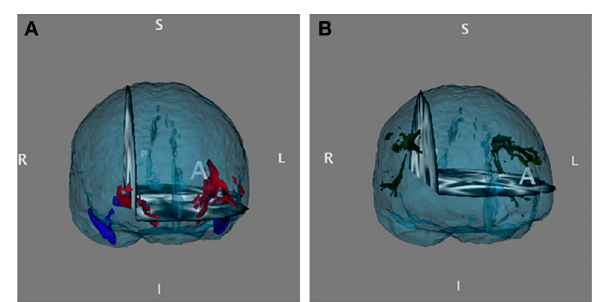
FIGURE 1 | (A) Right and left uncinate fascicule masks and (B) right and left superior longitudinal fascicule, temporal part projected into the mean FA surface, based on the JHU white-matter tractography probabilistic atlas Hua et al.